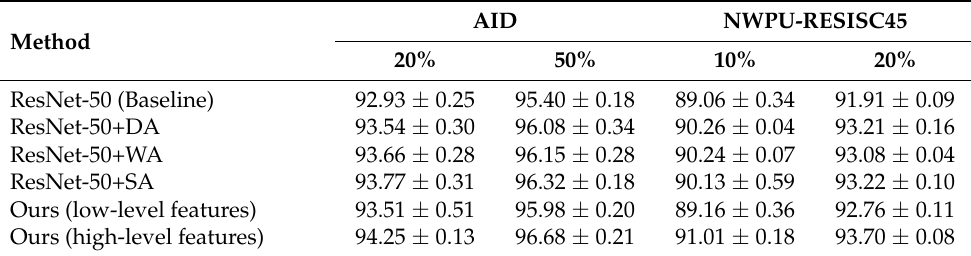
Figure 8. Grad-CAM visualization results. We compare the visualization results of the proposed AGMFA-Net (ResNet-50) with the baseline (ResNet-50) and three other multilayer feature aggregation methods. The Grad-CAM visualization is computed for the last convolutional outputs. Table 1. Ablation experimental results on two datasets with different training